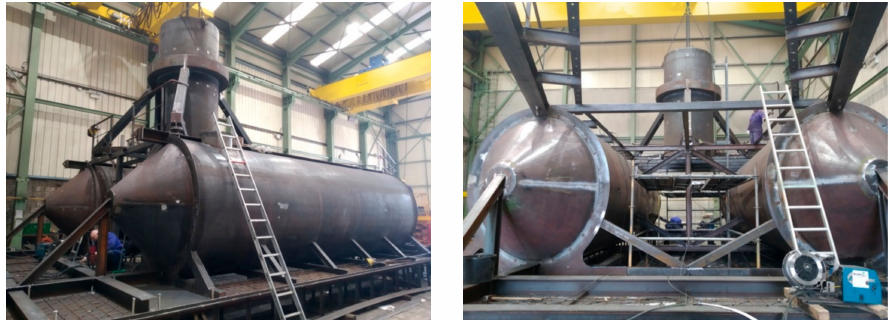
Figure 3. Building of the BlueSATH ® platform in the workshops. Source: Figure courtesy of Saitec [31].